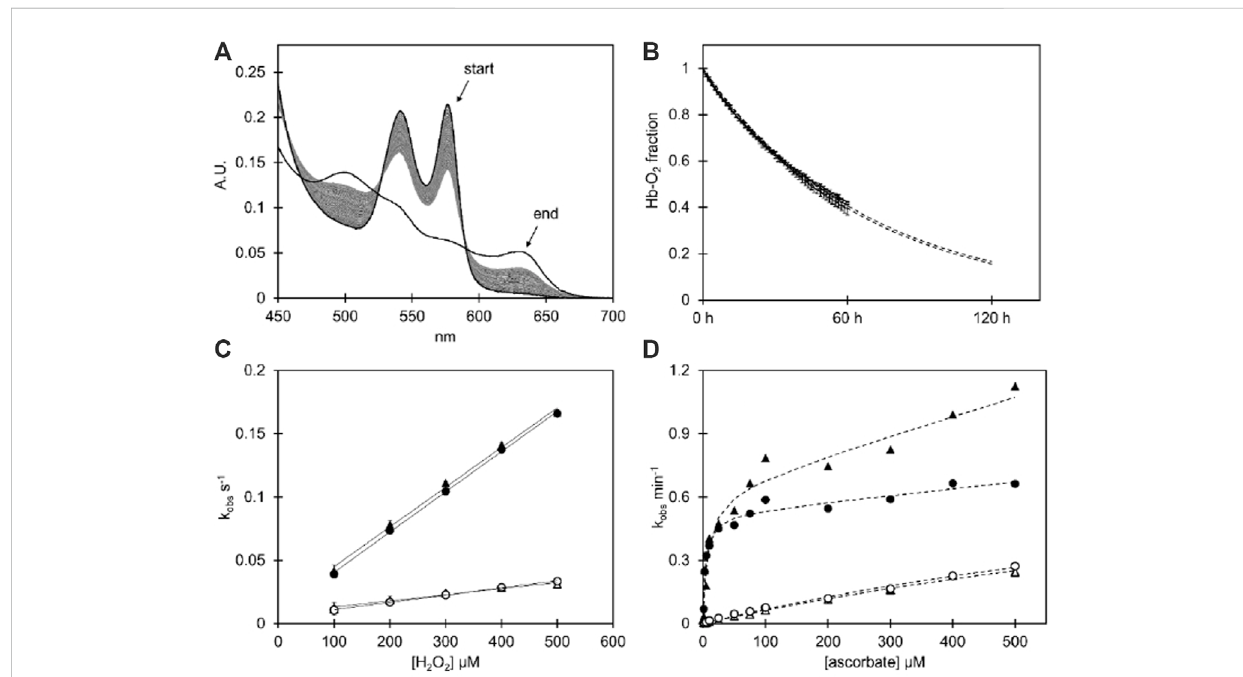
FIGURE 1 (A) Spectral series of the spontaneous autoxidation reaction of the HbF α 4 mutant during 60 h at 37 ° C in 100 mM phosphate buffer pH 7.4 supplemented with 4.6 U/mL superoxide dismutase, 414 U/mL catalase, and 1 mM EDTA using Hb at 20 µM heme. The end spectrum shows the potassiumferricyanide-inducedcompleteferricstateofthesamesample. (B) TheautoxidationdecayofferrousO 2 -boundHbasresolvedbycomponent analysis for wt HbF and the HbF α 4 mutant. The data is shown with error bars representing the standard deviation (n = 3), and the fi tted single exponential decay equation is depicted as dashed lines, which extend beyond 60 h to represent the extrapolated continued reaction. (C) The graph showsthek obs plotted against theH 2 O 2 concentrationoftheH 2 O 2 -inducedferrylformationexperiment(Fe 3+ → Fe 4+ ),withalinear fi ttingofthesecond- orderrateconstantµM − - s -1 . (D) Theplotshowsthek obs plottedagainstascorbateconcentrationduring theinducedreductionfromtheferryltotheferric state ofHb(Fe 4+ → Fe 3+ ).The datais fi ttedwitharectangular hyperbolaplusalinear equation for thefastphase ( α -subunit),and asingle hyperbolaforthe slowphase( γ -subunit).Forgraphs (C,D) ,thefastphasek obs areshownwith fi lledsymbolsandtheslowk obs haveopensymbols.CirclesrepresentwtHbF and triangles represent HbF α 4 mutant. For experimental details cf Material and